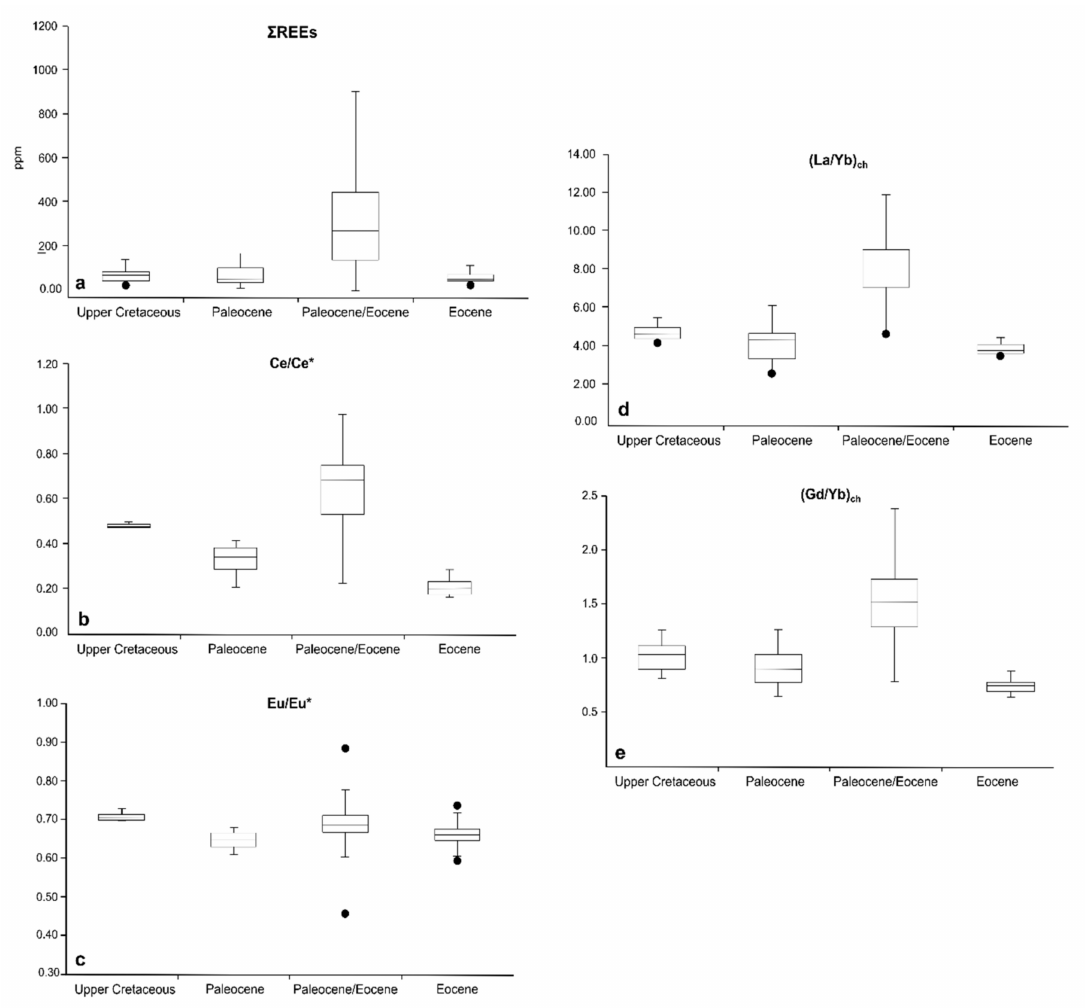
Figure 9. Box and whisker plots of Σ REEs ( a ) and selected geochemical proxies ( b ) Ce/Ce*; ( c ) Eu/Eu*; ( d ) (La/Yb) ch ; ( e ) (Gd/Yb) ch ) calculated for the studied samples grouped by deposition age. Symbols are as shown in Figure